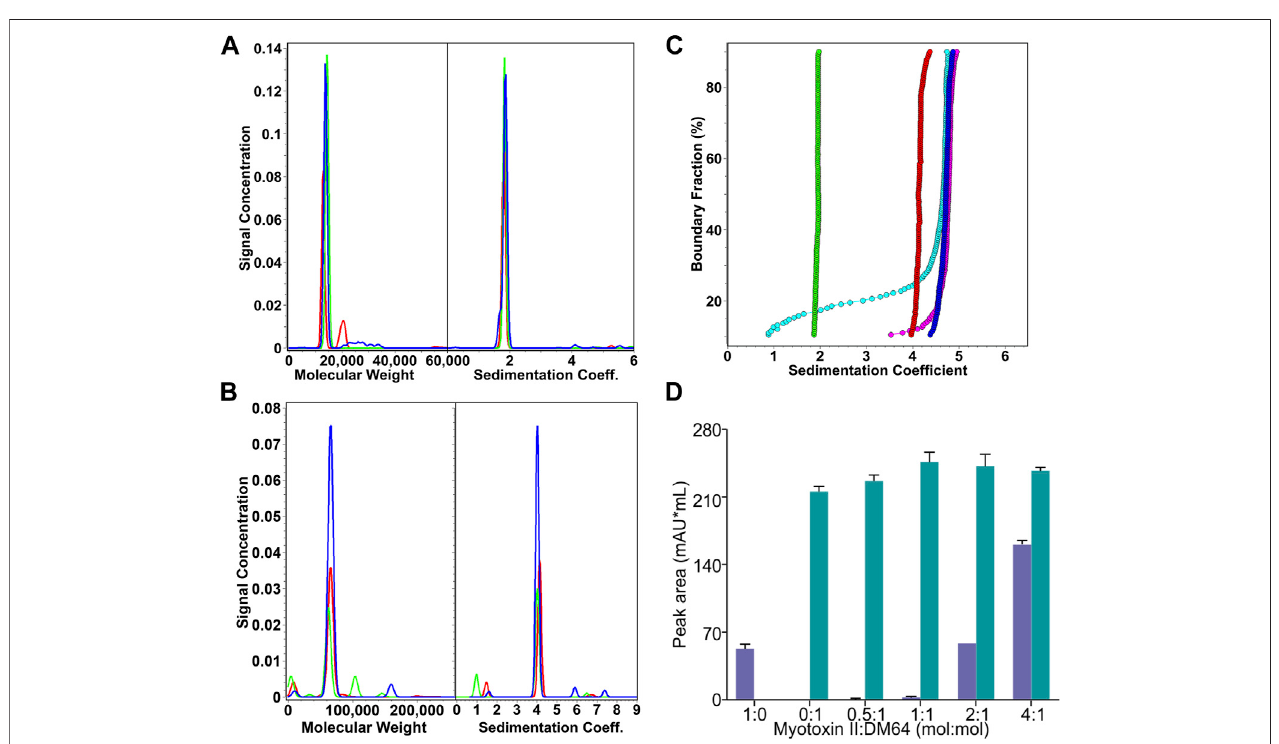
FIGURE2| Analysisofthestoichiometryoftheinteraction betweenDM64andmyotoxinII. (A) Sedimentation coef fi cientdistributionsandmolarmassestimatesof myotoxinIIcontrols(25.7 µM,green;82.6 µM,red;119 μ M,blue). (B) Sedimentationcoef fi cientdistributionsandmolarmassestimatesofDM64controls(0.81 μ M,red; 4.2 µM, green; 9.0 µM, blue) (C) van Holde-Weischet integralG(s)distributions ofmyotoxin II:DM64 mixtures (1:1, blue; 2:1, magenta; 4:1, cyan) and myotoxin II(green) and DM64 (red) monomeric controls. (D) Size exclusion chromatography analysis of myotoxin II and DM64 mixed at different molar ratios. The peak areas in the chromatograms were integrated and plotted. Because the retention times for DM64 alone and the complex DM64-myotoxin II are very similar, they were plotted as the sum of co-eluted peaks (green bars). Free myotoxin II eluted at a different elution time (blue